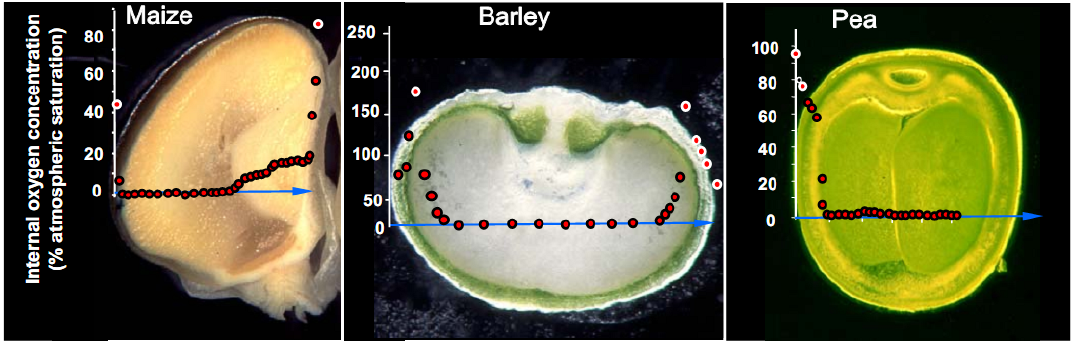
Figure 1. Characteristic oxygen profiles measured in seeds of maize, barley and pea (left, middle and right panel, respectively). Oxygen was measured using microsensors along the x-axis. Oxygen concentration is given in % of atmospheric saturation (100% corresponds to 258 µM at 25 °C). Please note different scales for y-axis. After measurement, seeds were cross-sectioned along the pathway of sensor penetration. The overlay of tissue structure an oxygen gradient represents the “oxygen map”. Profiles for maize and pea were measured in darkness, while in barley seeds were illuminated with 700 µmol quanta m -2 s - 1 . Oxygen maps were taken from [20, maize], [21, barley] and [19,